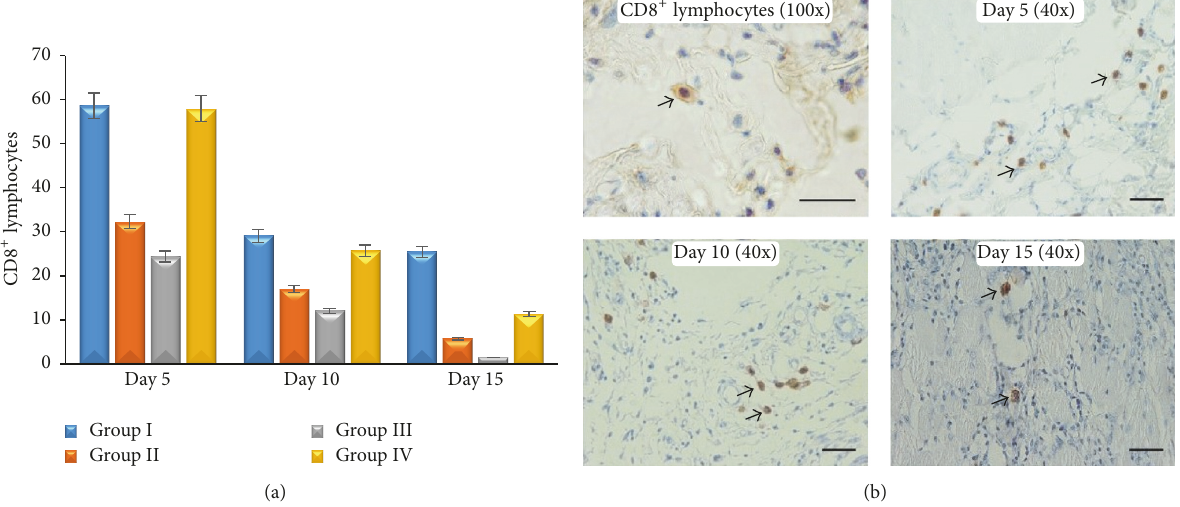
Figure 5: The average number of CD8 + lymphocytes (a); microscopical examination of CD8 + lymphocytes on skin wound (IHC antibody anti CD8 + , DAB, scale bar 50 𝜇